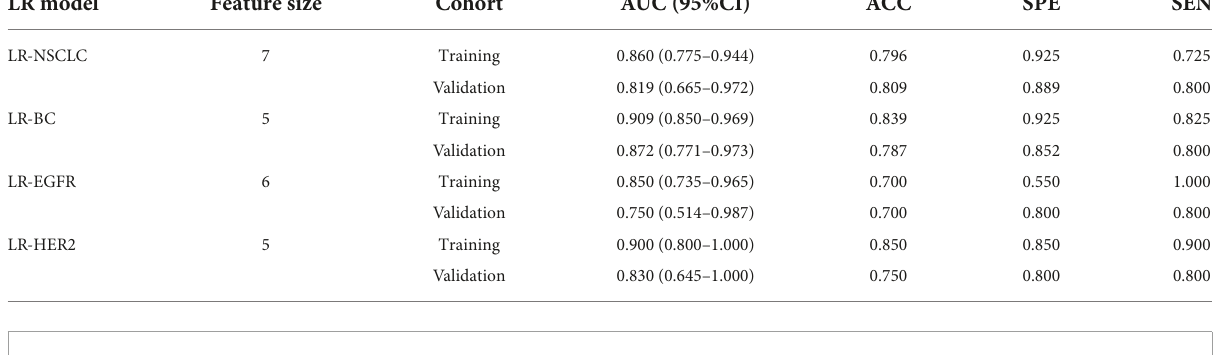
TABLE 3 Prediction performance of the established logistic regression models.